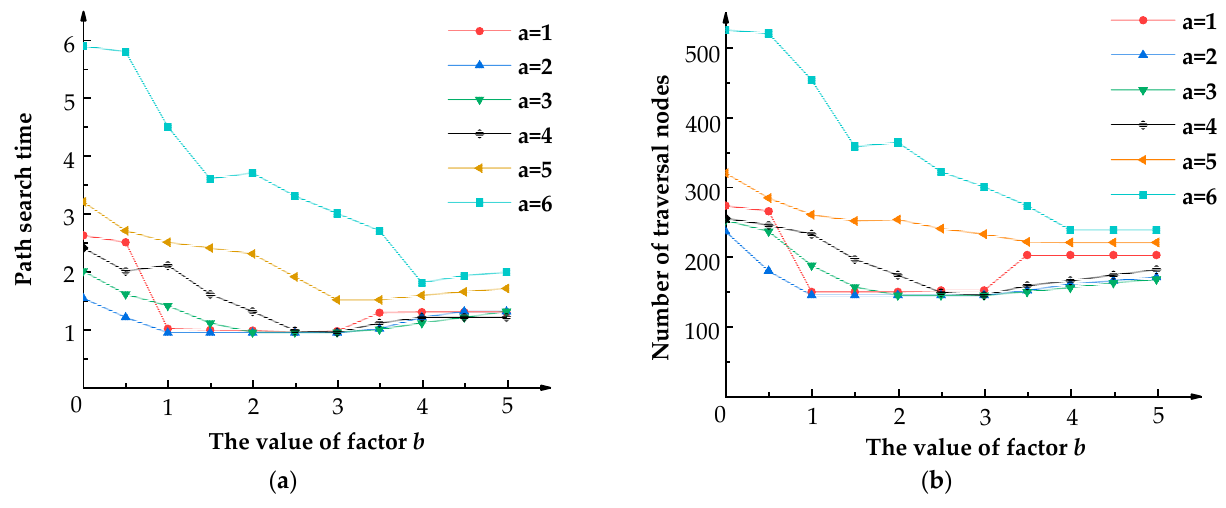
Figure 5. Results of evaluation indexes with di ff erent parameters: ( a ) path search time with di ff erent parameters; and ( b ) number of traversal nodes with di ff erent parameters.